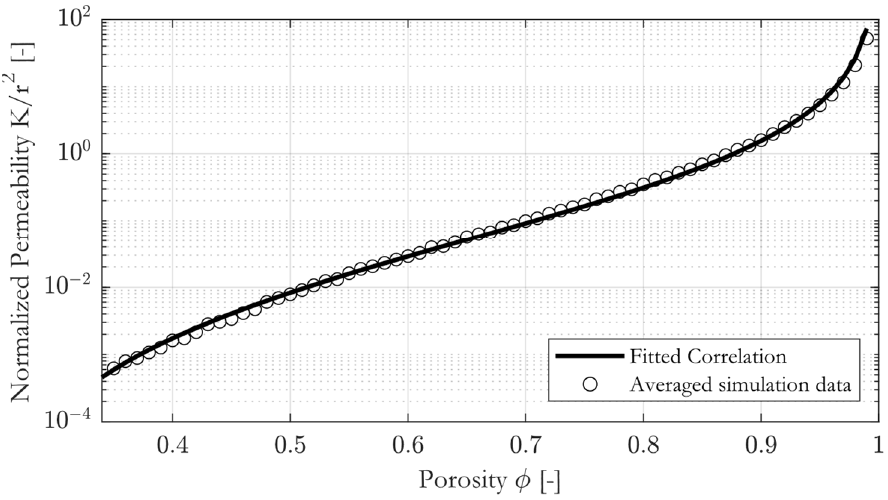
Figure 10. Constitutive permeability–porosity correlation with geometrical mean of simulation data. The fitted correlation almost perfectly crosses the averaged data points, and R 2 = 0.998 is obtained.